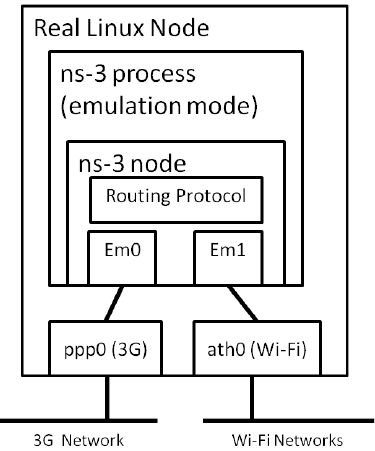
Figure 1: Emulation in a vehicular network scenario.